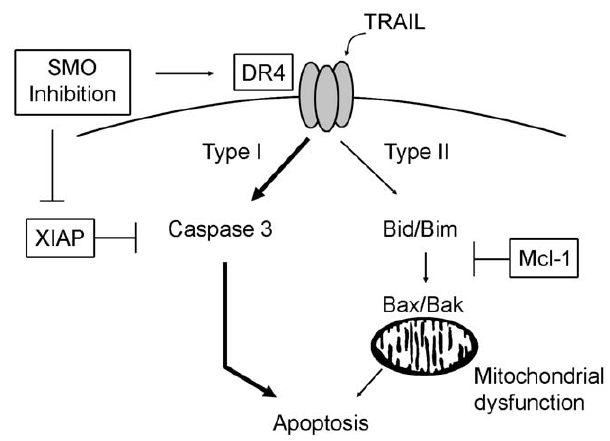
Figure 7. SMO inhibition sensitizes cells to TRAIL-induced apoptosis by increasing DR4 and decreasing XIAP protein levels, thereby switching cells from Type II to Type I death receptor signaling. Schematic illustration of the interaction of Hedgehog and TRAIL signaling in cholangiocarcinoma cells. Death signaling upon TRAIL binding to DR4 normally is dependent on mitochondrial dysfunction (induced by Bid/Bim as well as Bak/Bax activation) to induce cholangiocarcinoma cell death (Type II pathway), a pathway blocked by elevated Mcl-1 protein levels in cholangiocarci- noma cells. Alternately, following DR4 ligation, robust caspase 3 activation can induce Type I death signaling, a pathway inhibited by XIAP expression under normal conditions. Inhibition of SMO expression or activity sensitizes cells to TRAIL via increasing DR4 [19] and decreasing XIAP levels, thereby switching cells from Type II to Type I death receptor signaling and promoting apoptosis.